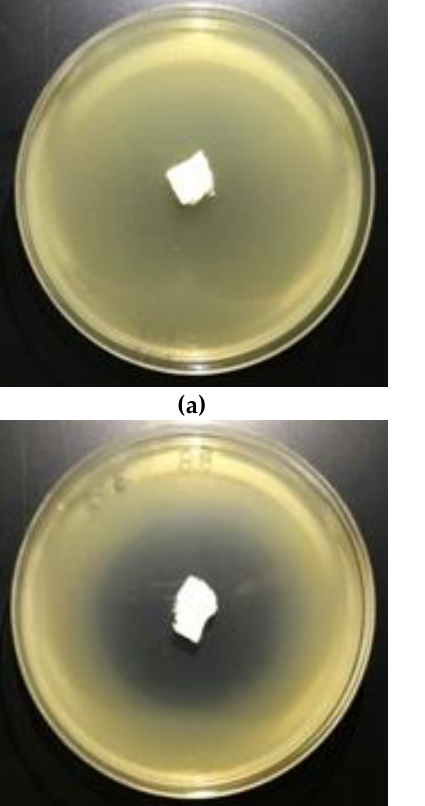
Figure 8. The nonwovens antimicrobial activity tests against E. Coli. Inhibition zones of bacterial growth on Petri dishes, modified PLA nonwoven with fosfomycin coating pastes concentrations: a –